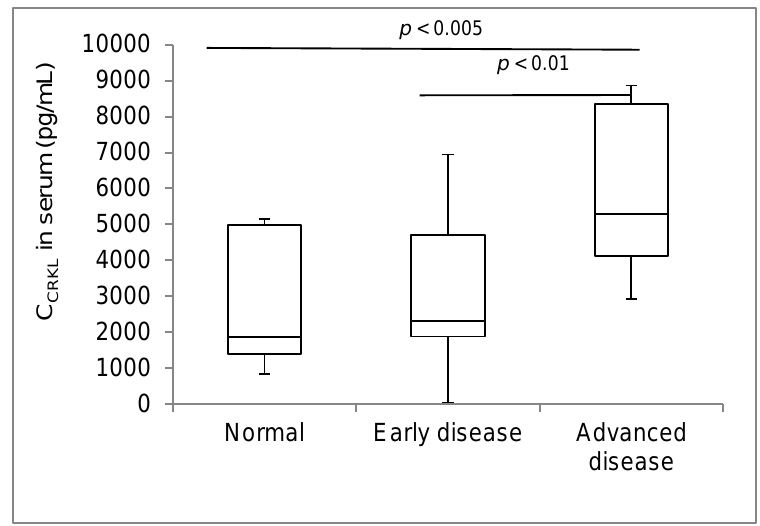
Figure 4. Assessment of secreted Crk-like protein (CrkL) levels in breast cancer patients’ sera. The CrkL concentration (C CrkL ) was measured in the sera from breast cancer patients using Enzyme Linked Immuno-Sorbent Assay (ELISA).